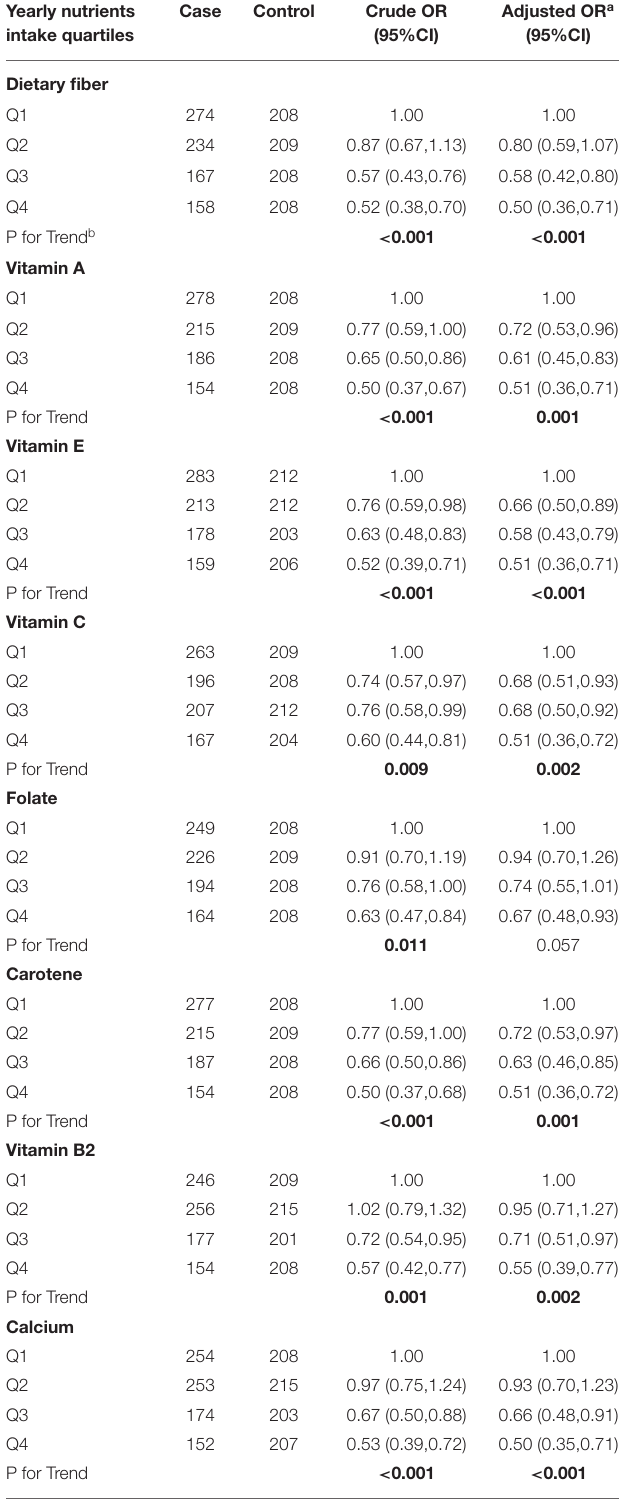
TABLE 7 | Odds ratios (ORs) and 95% confidence intervals (CIs) for the association of yearly nutrients intake from solanaceous vegetables and colorectal cancer